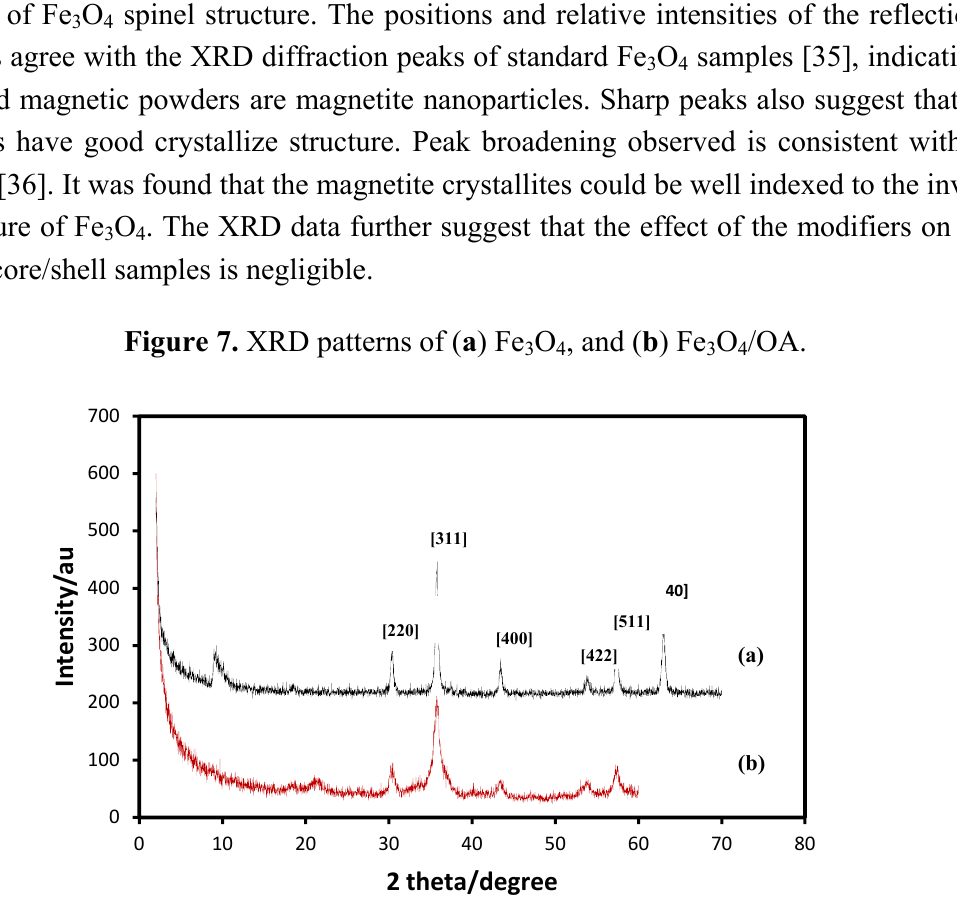
Figure 7. XRD patterns of ( a ) Fe